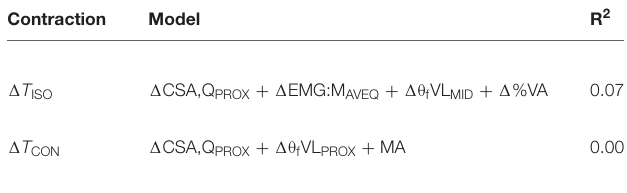
TABLE 5 | Regression models using the previously identified “best-fit” model parameters for predicting maximal torque in a cross-sectional analysis (Trezise et al., 2016) to determine whether adaptations in these variables were associated with changes in strength following